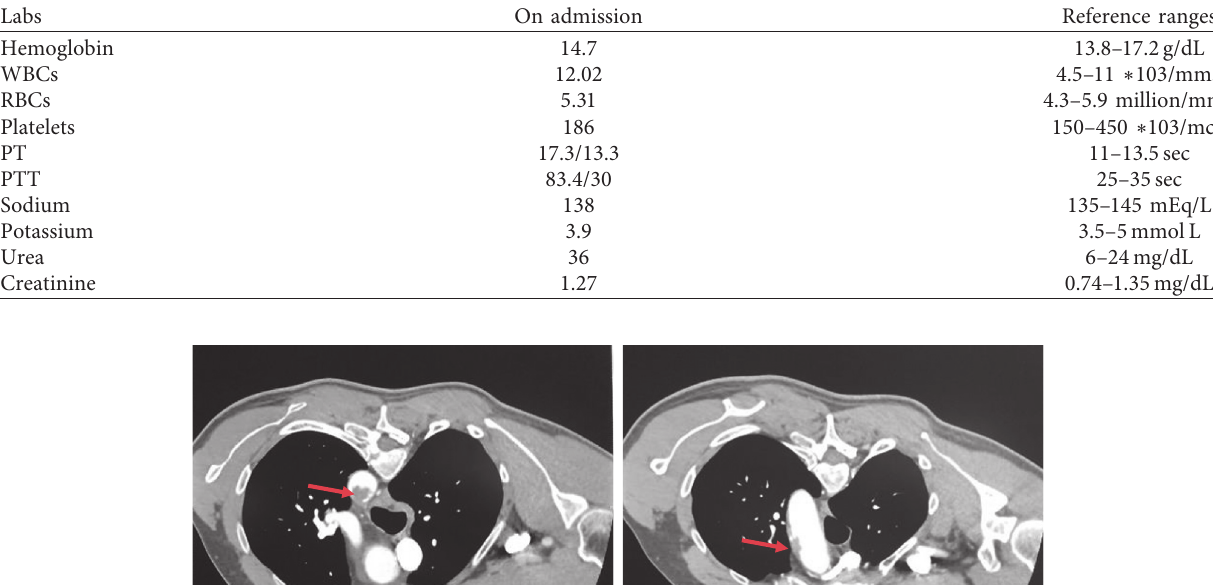
Table 1: Laboratory results on admission.